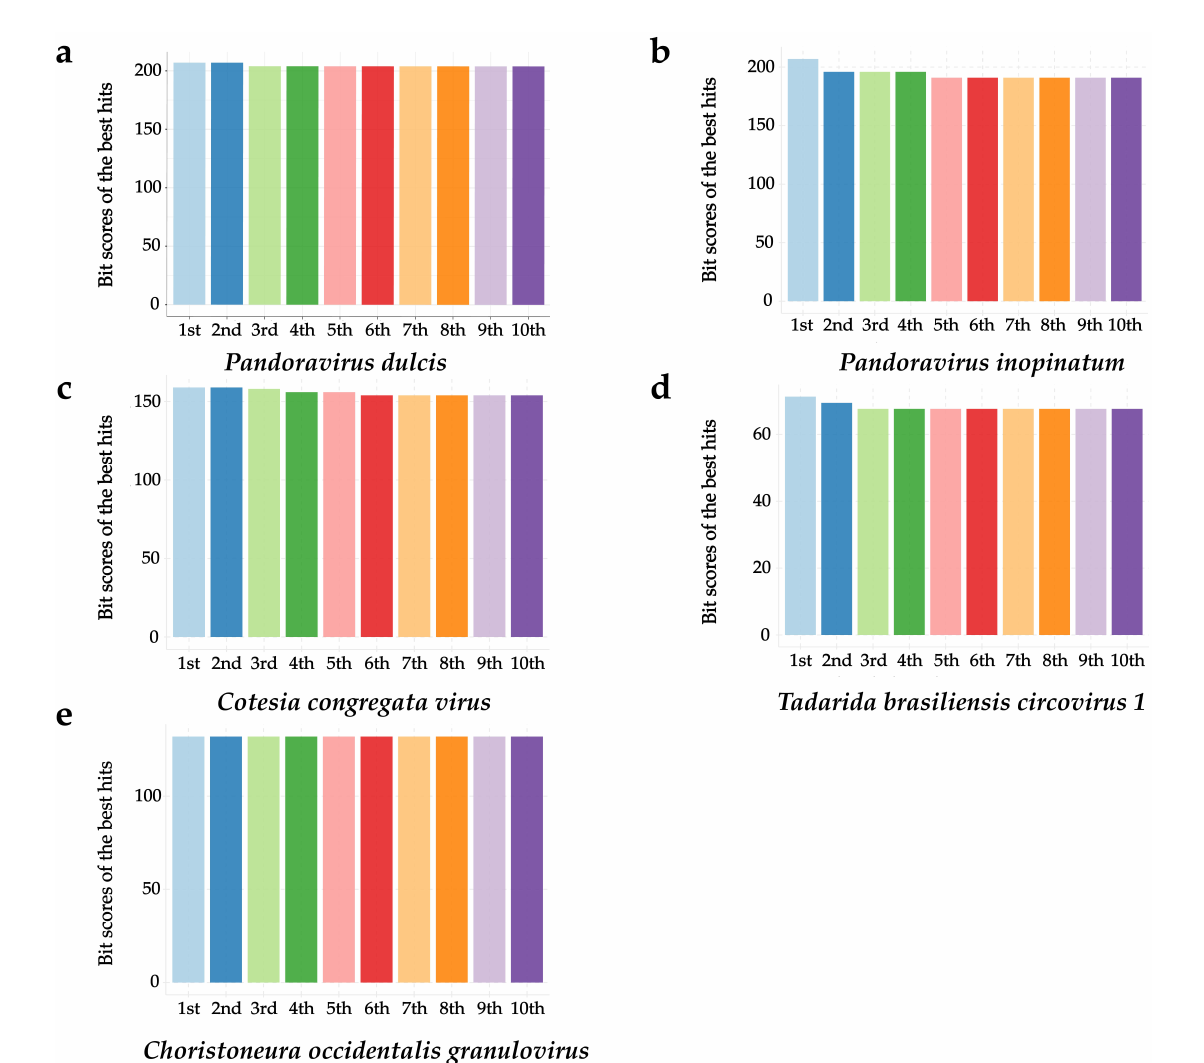
Figure 2. The alignment quality of 10 HFs in 5 virus species with the most HFs in the B. belcheri beihai genome. The averages of the Bit scores of the 10 HFs with the smallest E-values were